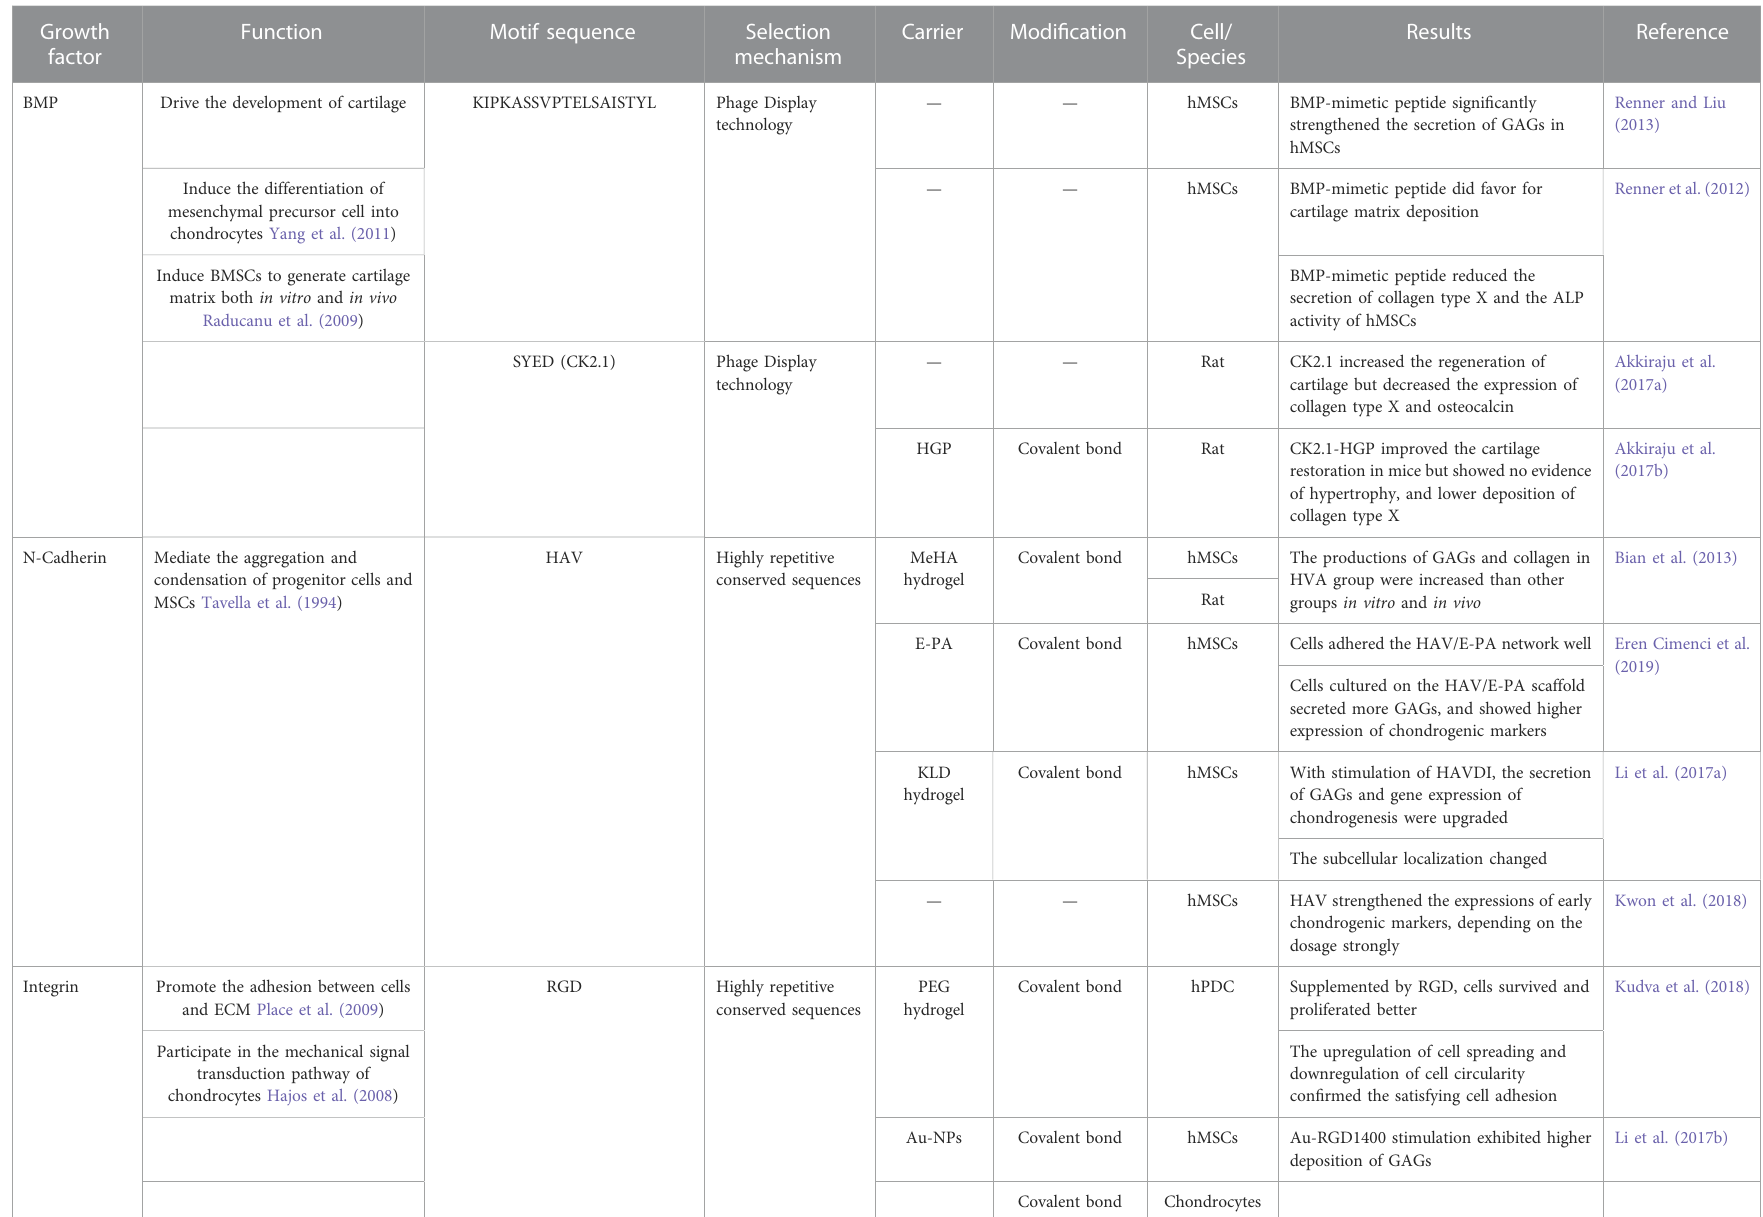
TABLE 1 ( Continued ) Functional motifs applications for cartilage tissue